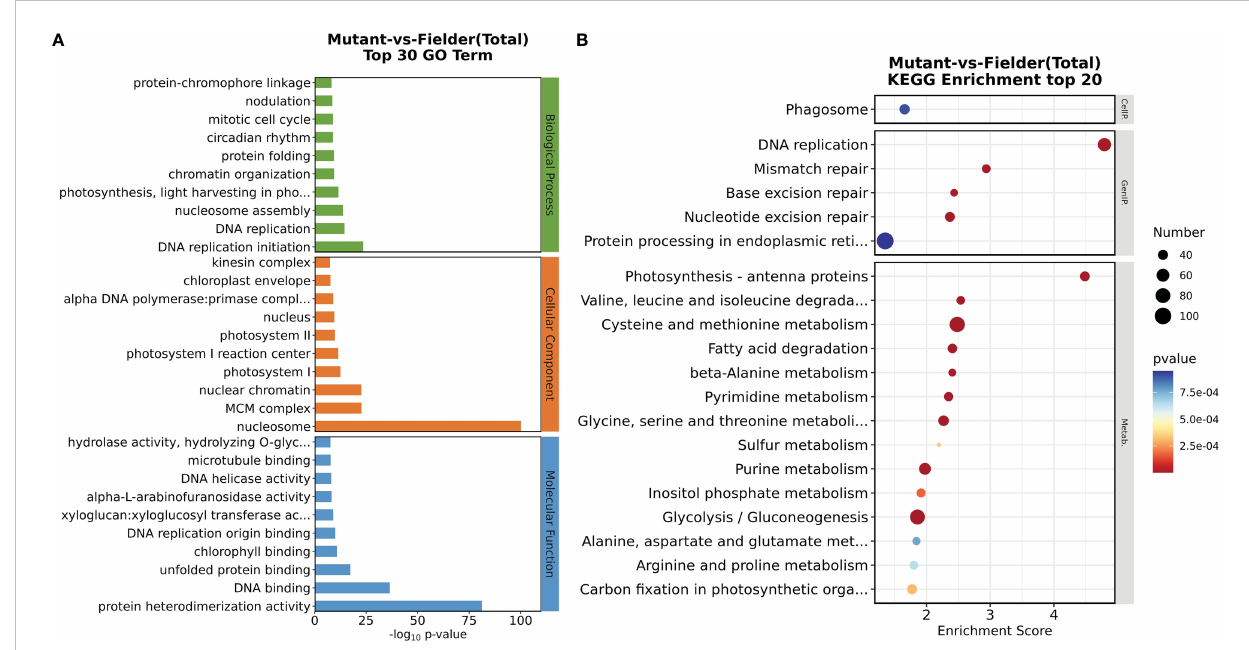
FIGURE 5 GO and KEGG analysis of the DEGs. (A) Classi fi cation of the DEGs by GO analysis performed on the website GENE ONTOLOGY (). The top 30 enriched terms are shown. (B) Scatter plots of KEGG pathway-enrichment statistics performed on the website Kyoto Encyclopedia of Genes and Genomes (). The top 20 enriched pathways are shown. The vertical axis represents the pathway categories. The size of the “ number ” represents the number of genes clustered in a singling pathway. The bigger the point size, the more genes in the